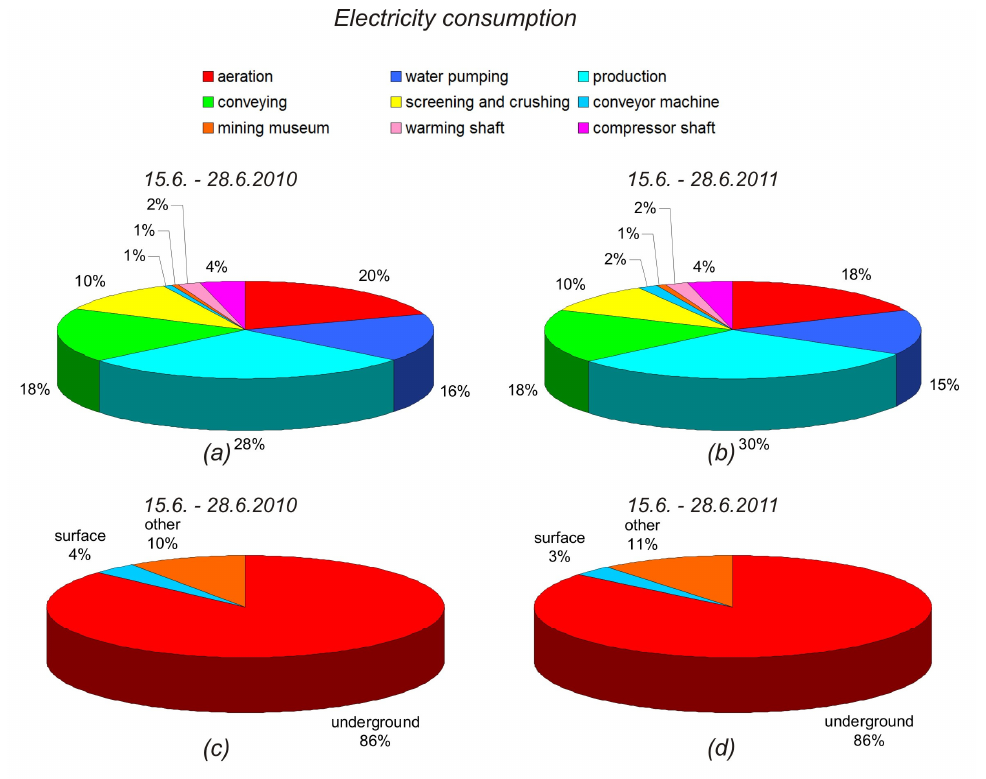
Figure 7. Electricity consumption distribution in VCM for the month of July: ( a ) by different consumers in 2010; ( b ) by different consumers in 2011; ( c ) by location in 2010; ( d ) by location in